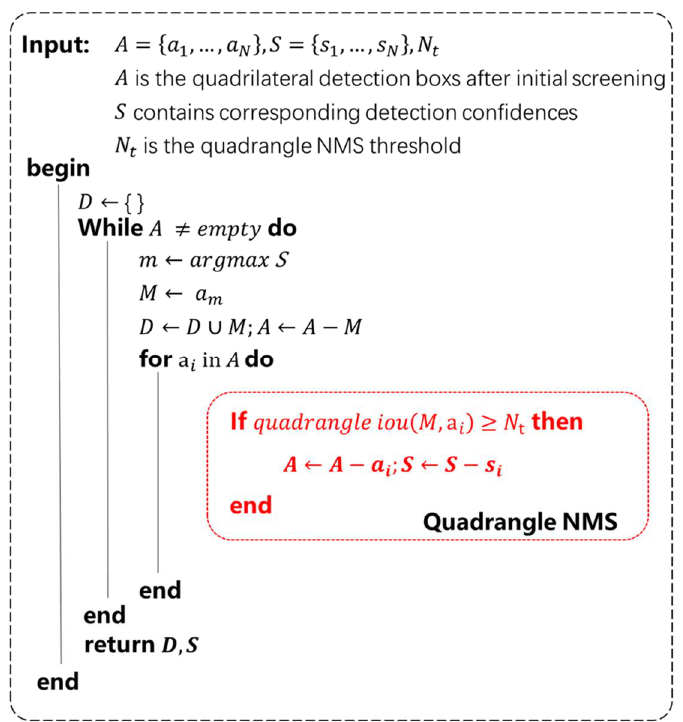
Figure 5. Algorithm step diagram of quadrangle NMS.